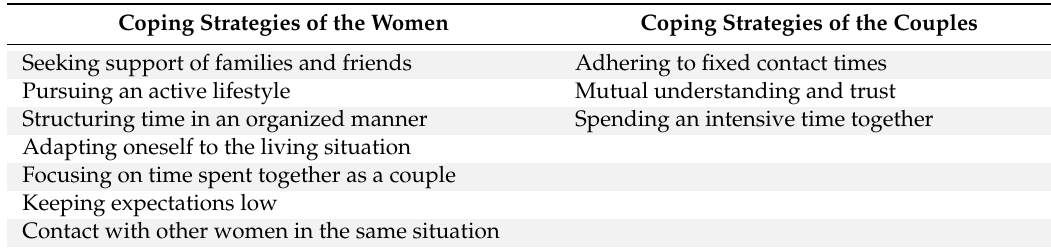
Table 4. Coping strategies of the women and the